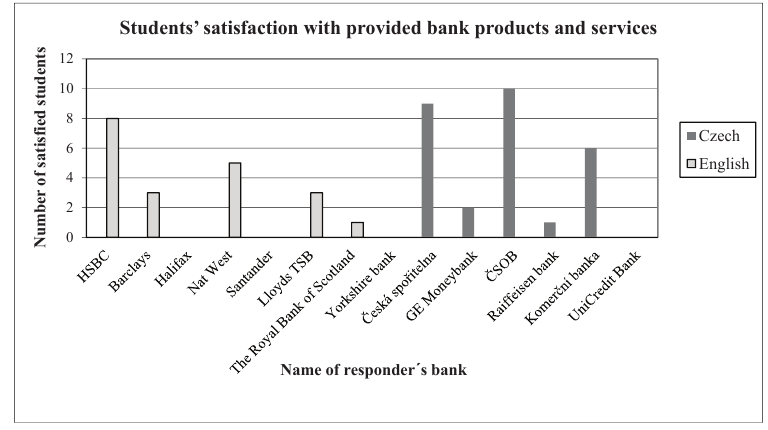
Fig. 2 – Students’ satisfaction with banking products and services in the two investigated countries. Source: Author´s